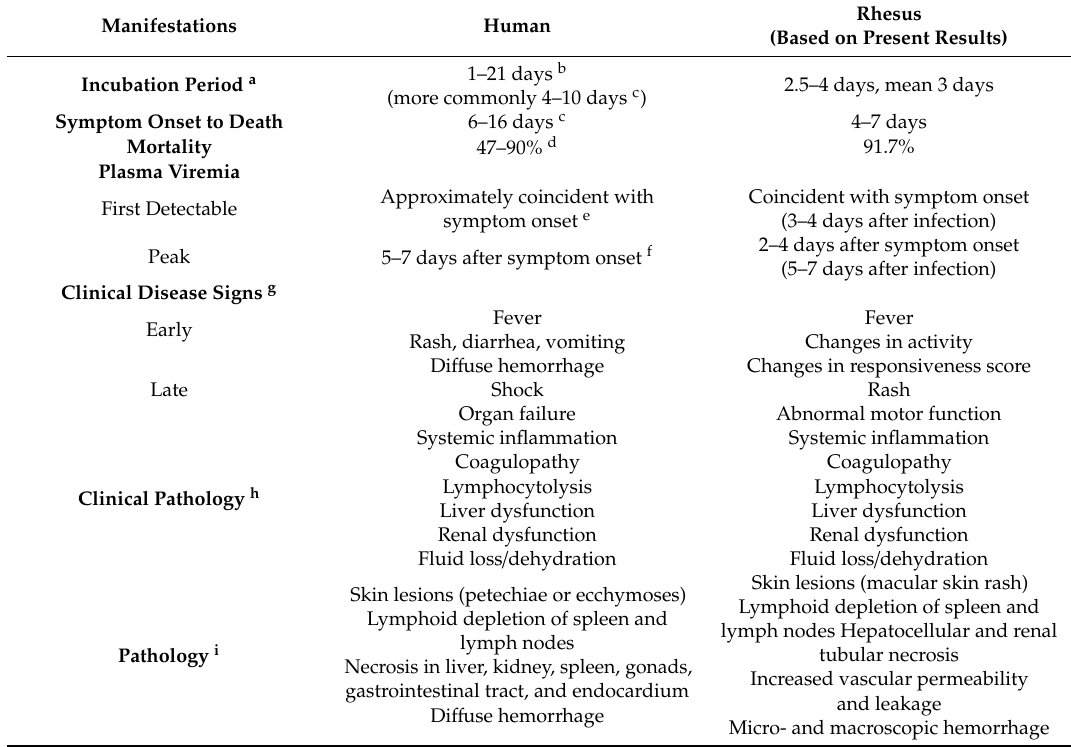
Table 4. Disease manifestations in humans and rhesus